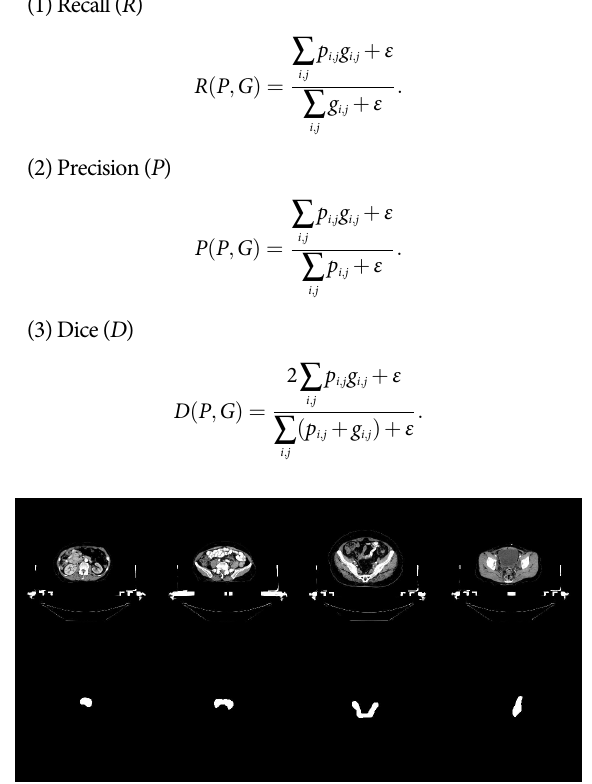
Fig. 2 Examples of dataset. The upper row includes four CT images with improved contrast, and the lower row includes their ground truth of the CTV targets.